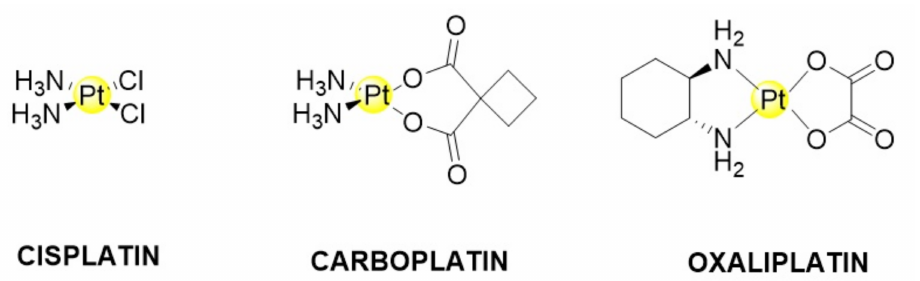
Figure 1. Pt-based drugs. Cisplatin, carboplatin and